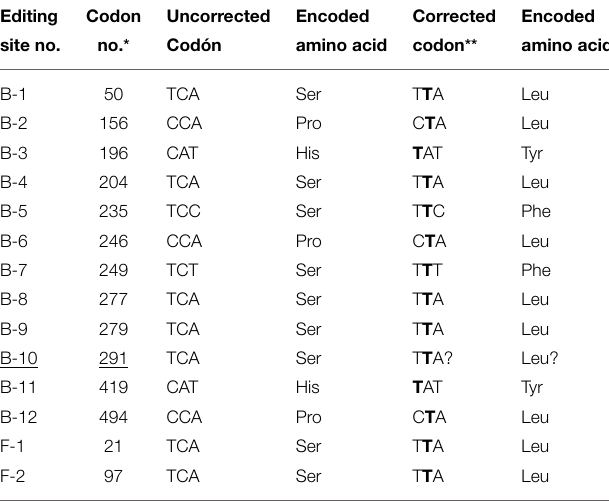
TABLE 1 | ndhB and ndhF editing sites in